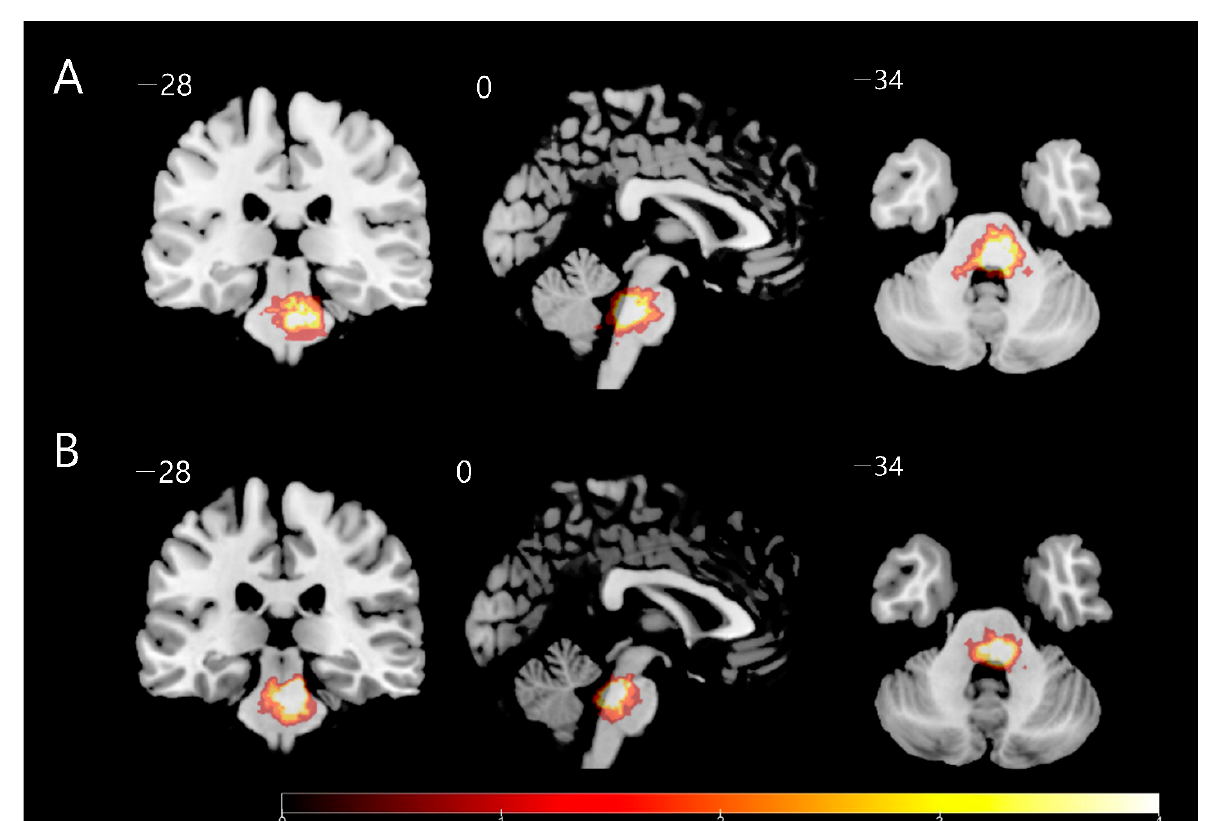
Figure 2. Lesion overlaps in the ( A ) control and ( B ) central post-stroke pain groups in patients with pontine hemorrhage. Left-sided lesions are flipped to the right. Different colors represent numbers of voxels in the superimposed region of interest. Numbers indicate Montreal Neurological Institute